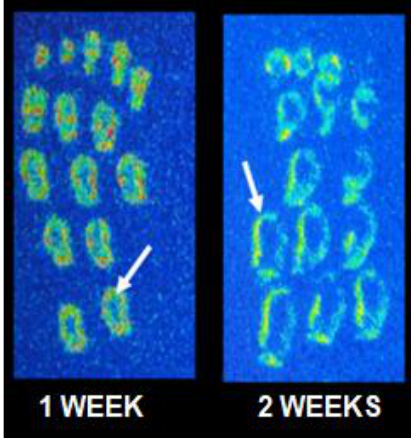
Figure 6. Illustrative [ 11 C]( R )-PK11195 autoradiography images of mammary murine tumor at 1 and 2 weeks after 4T1 cell inoculation. The white arrows indicate tumor edge uptake.